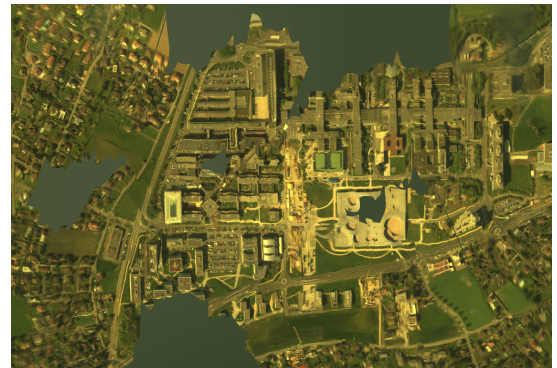
Figure 3. projection of hyperspectral data acquired while flying over EPFL (Lausanne, Switzerland), visualised in our software HypOS.